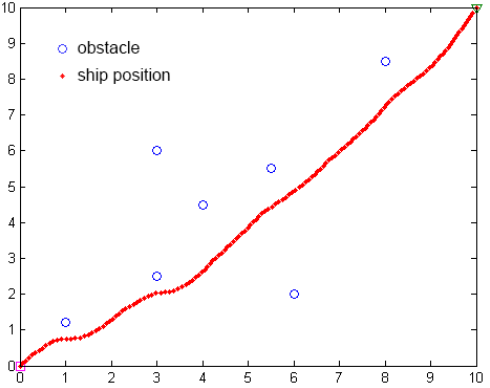
Figure 21. The simulation of path planning of APF.